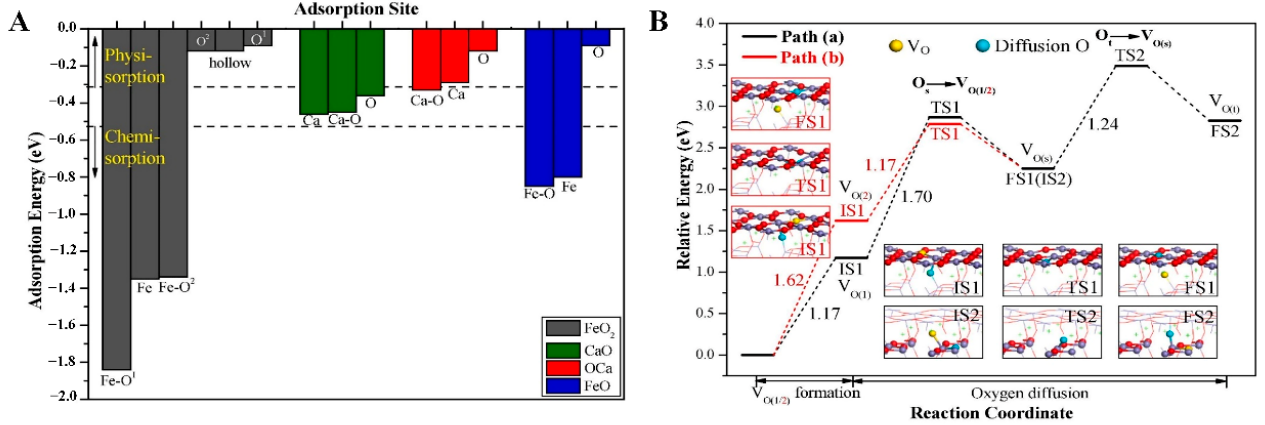
Figure 13. ( A ) Comparison of CO adsorption energies on FeO 2 -, CaO-, FeO-, and OCa-terminated Ca 2 Fe 2 O 5 (0 1 0) surfaces. ( B ) The pathways and energy profiles for oxygen diffusion in Ca 2 Fe 2 O 5 . Adapted with permission from Ref. [152], copyright 2020, Elsevier.